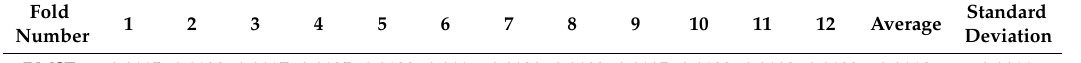
Table 4. Results of the k-fold cross-validation.